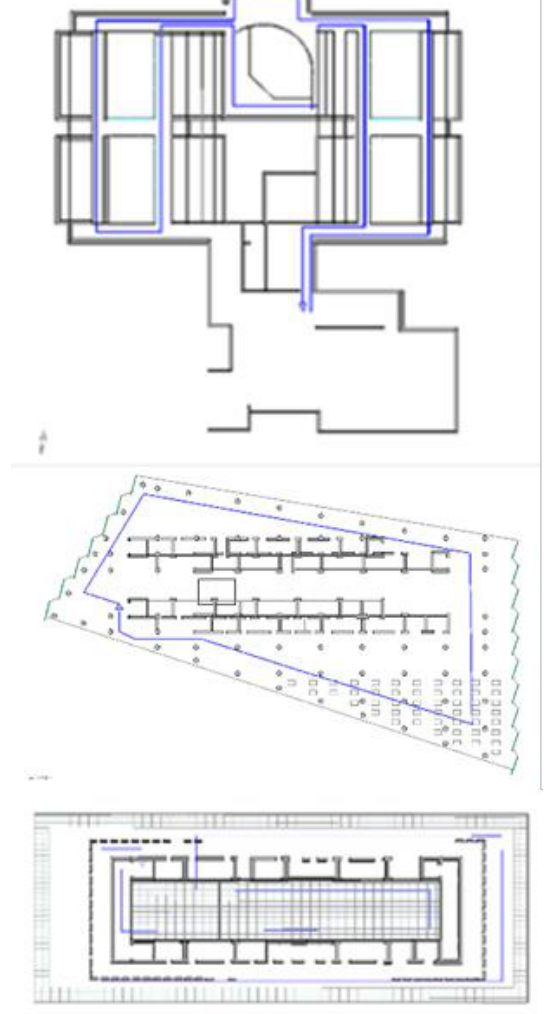
Figure 5 : the route plan for the case of Prehistoric Departmental Museum and Museum of the